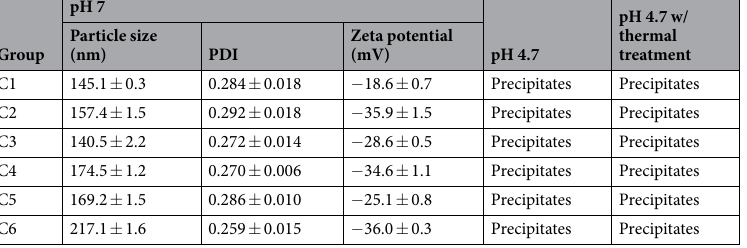
Table 3. Particle size, PDI, and zeta potential of control groups under different pH and condition.